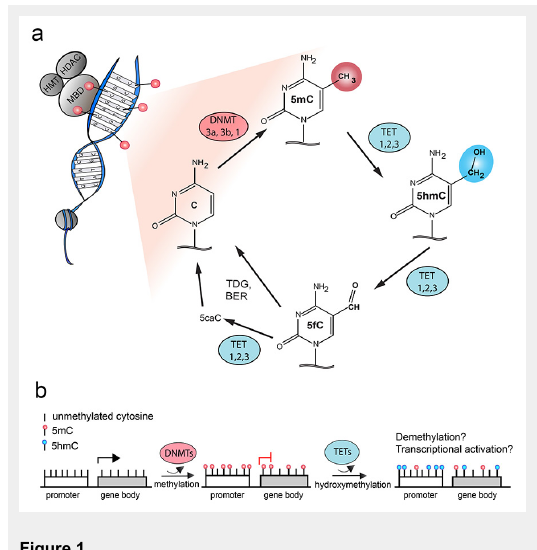
DNA methylation and hydroxymethylation. Cytosine modifications in DNA have functional consequences on gene expression. (a) Cytosine can be methylated by DNMT enzymes to give rise to 5mC, which can be oxidised by TET enzymes to 5hmC and further products (5fC and 5caC). In an active demethylation pathway, these products of TET enzymatic activity are likely to be excised and repaired by the thymine-DNA glycosylase enzyme and base excision repair mechanisms to regenerate the unmodified cytosine. Methylated DNA can be recognised by MBD proteins that can recruit histone modifying complexes (HMTs and HDACs). (b) DNA methylation occurs at regulatory regions (such as promoters), but also in gene bodies. DNMT enzymes are responsible for 5mC deposition, often resulting in the transcriptional repression of the methylated promoter. TET proteins activity can lead to demethylation with a potential for transcriptional activation. 5caC = 5-carboxylcytosine; 5fC = 5-formylcytosine; 5hmC